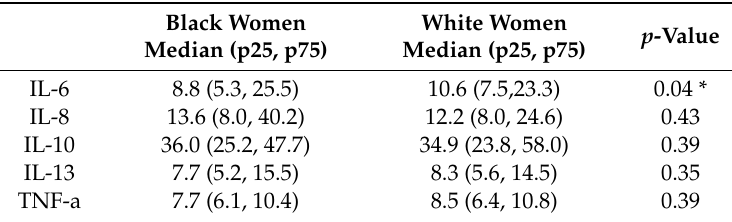
Table 6. Median cytokine levels stratified by